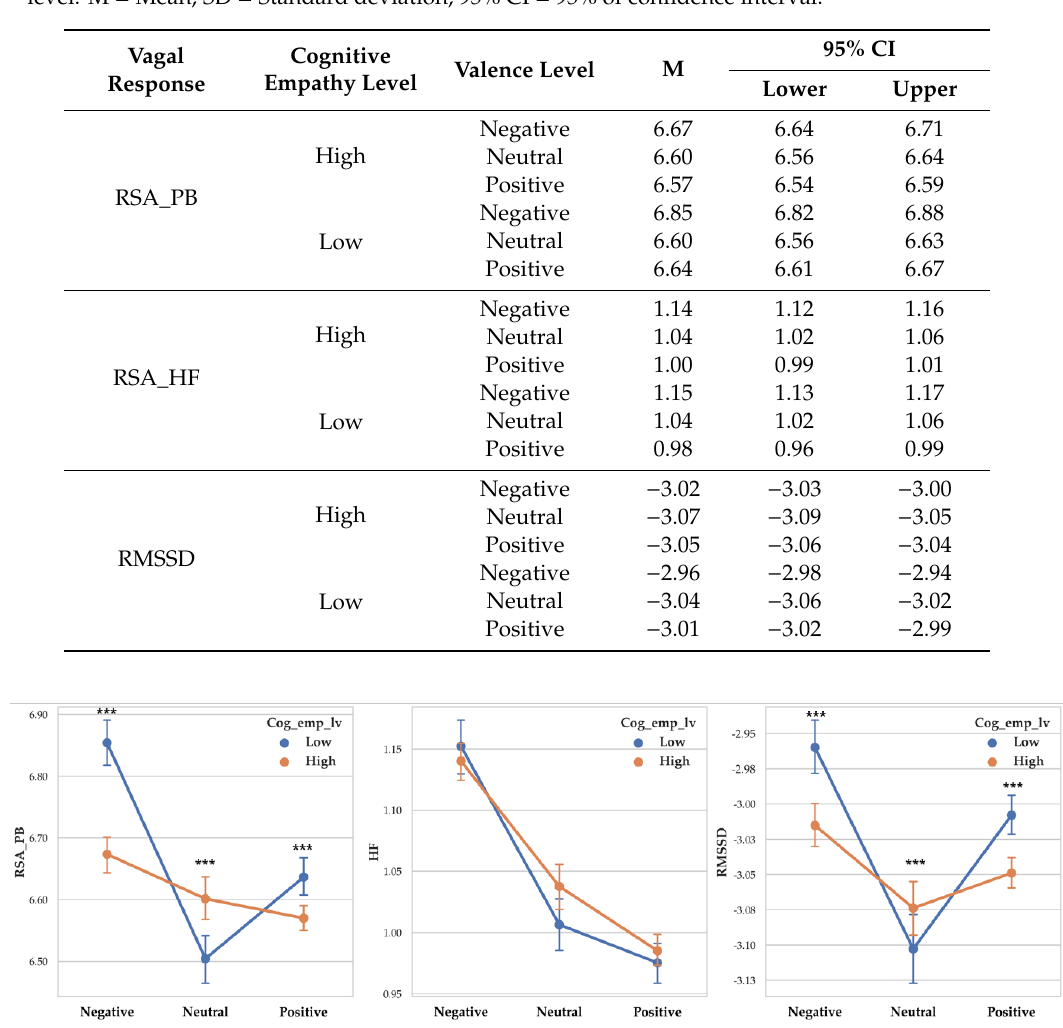
Table 4. Descriptive statistics of vagal response depending on cognitive empathy level and valence level. M = Mean, SD = Standard deviation, 95% CI = 95% of confidence interval.